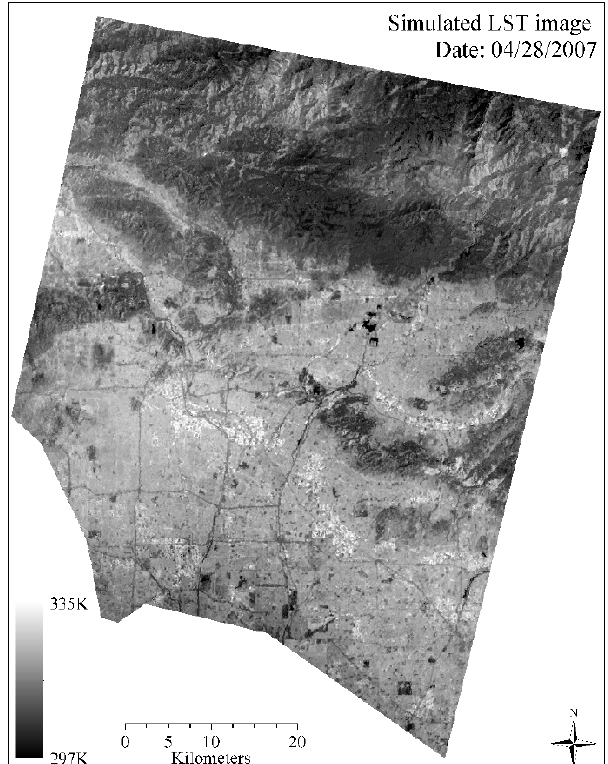
Figure 2. Simulated Advanced Spaceborne Thermal Emission and Reflection Radiometer (ASTER)-like land surface temperatures (LST) image on date 04/28/2007 (90 m spatial resolution).